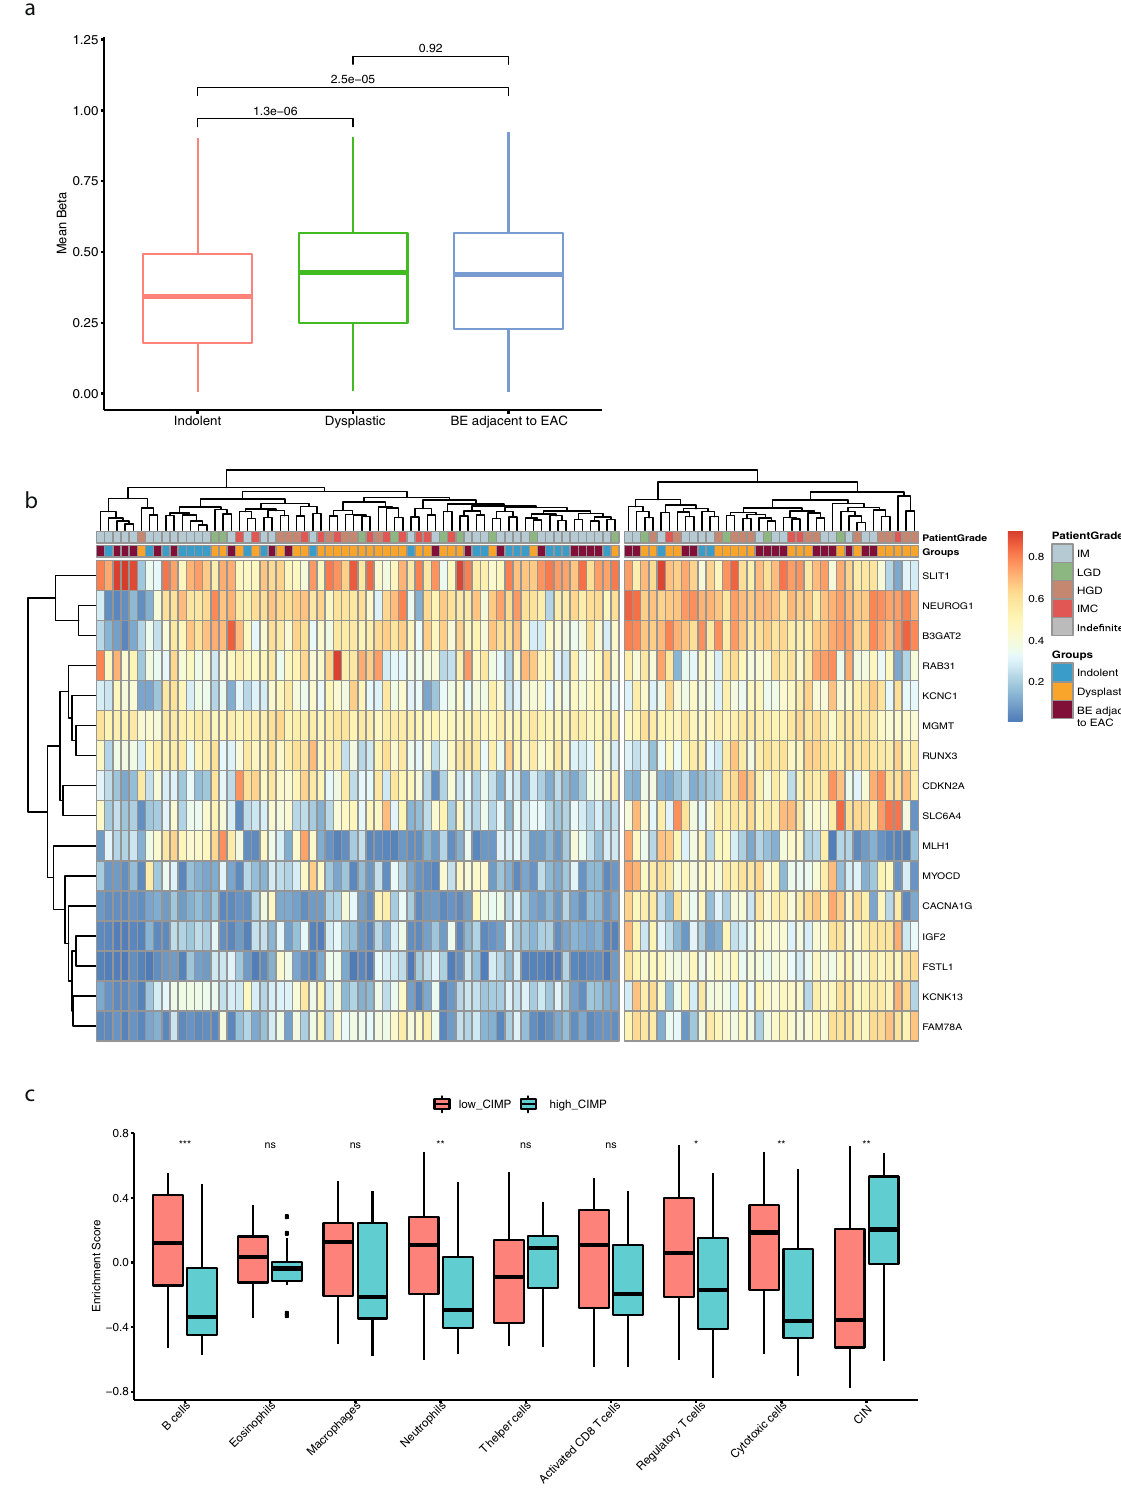
Fig. 5 CIMP marker analysis. a Boxplot representing mean methylation (beta) of CIMP marker genes across three groups of BE cases. N = 100. Boxplot centre line denotes median, box limits are upper and lower quartiles, whiskers denote 1.5* the interquartile range. Statistical signi fi cance calculated using Wilcoxon signed-ranked test. b Heatmap showing methylation levels for all CIMP marker genes and grouping of samples into low and high CIMP groups. Annotation of samples are shown on the top. c Enrichment of different immune cell types and chromosomal instability in low and high CIMP groups. Boxplot centre line denotes median, box limits are upper and lower quartiles, whiskers denote 1.5* the interquartile range. Statistical signi fi cance was calculated using Wilcoxon signed-ranked test. ns non-signi fi cant, * p -value < 0.05, *** p -value <